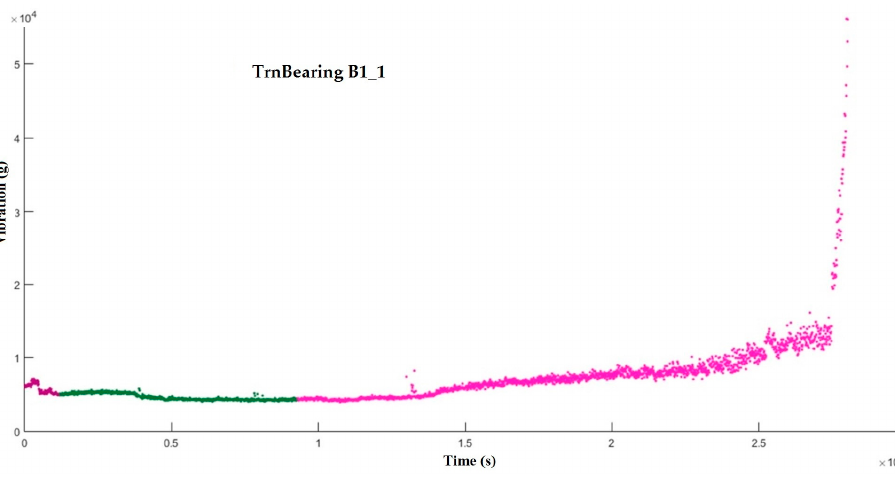
Energies 2020 , 13 , x FOR PEER REVIEW Figure 16. Expand_Local_Search result for PRONOSTIA dataset B1_1. Figure 16. Expand_Local_Search result for PRONOSTIA dataset B1_1. Figure 16. Expand_Local_Search result for PRONOSTIA dataset B1_1.